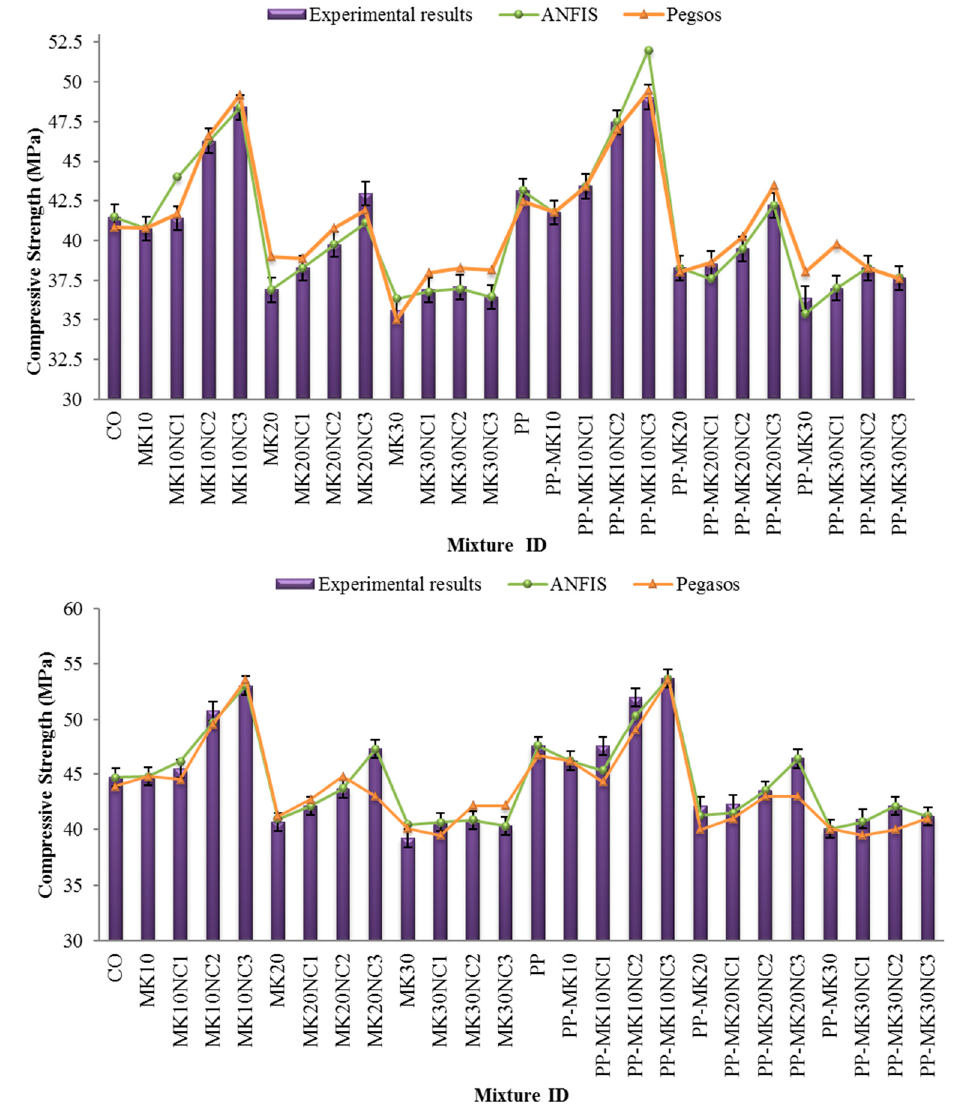
Figure 5. Compressive strength results at: 28 days ( top ); and 90 days ( below ).